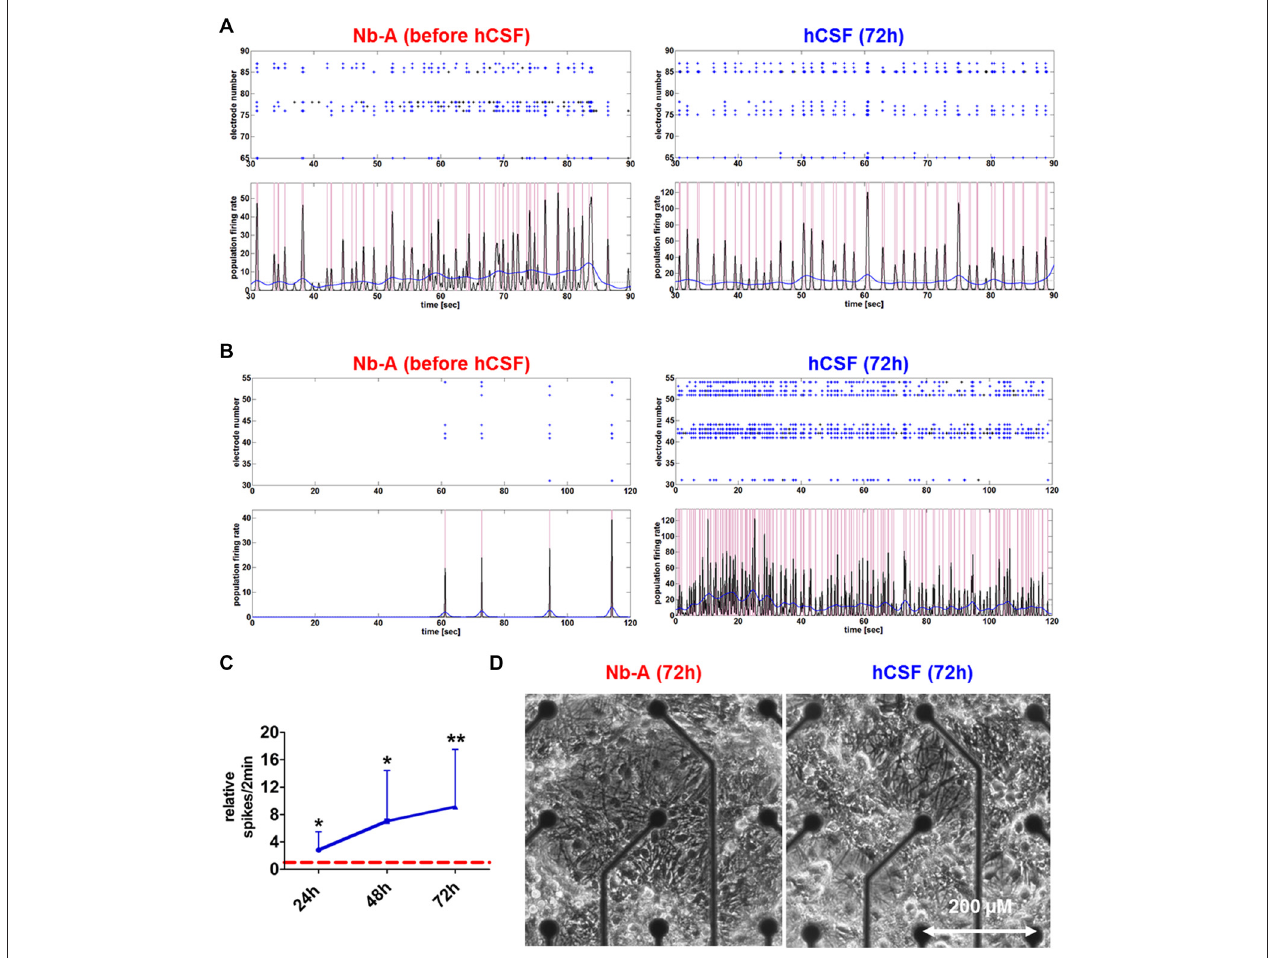
FIGURE 2 | Network activities and morphology of hippocampal neurons after prolonged exposure to human CSF (hCSF). (A) Examples of spike raster plotsand population firing ratesillustrate the activity of high-active mature hippocampal neurons (4 weeks cultured in Neurobasal-A (Nb-A) medium) before and after (72 h) exposure to hCSF. (B) Examples of spike raster plotsand population firing ratesillustrate the activity of low-active mature hippocampal neurons (4 weeks cultured in Nb-A medium) before and after (72 h) exposure to hCSF. (C) Diagram illustrates the relative change of spiking activity after the application of hCSF to high- and low-active hippocampal neuronal cultures (blue line) in relation to baseline activity recorded in cultivation media (red dotted line) (mean ± SD, 6 hCSF-samples used in 12 neuronal cultures obtained from three independent rat preparations). (D) Morphology of mature rat hippocampal neuronal cells (28 div) 3 days after the application of either fresh Nb-A-based media or hCSF. ∗ p < 0.05; ∗∗ p <